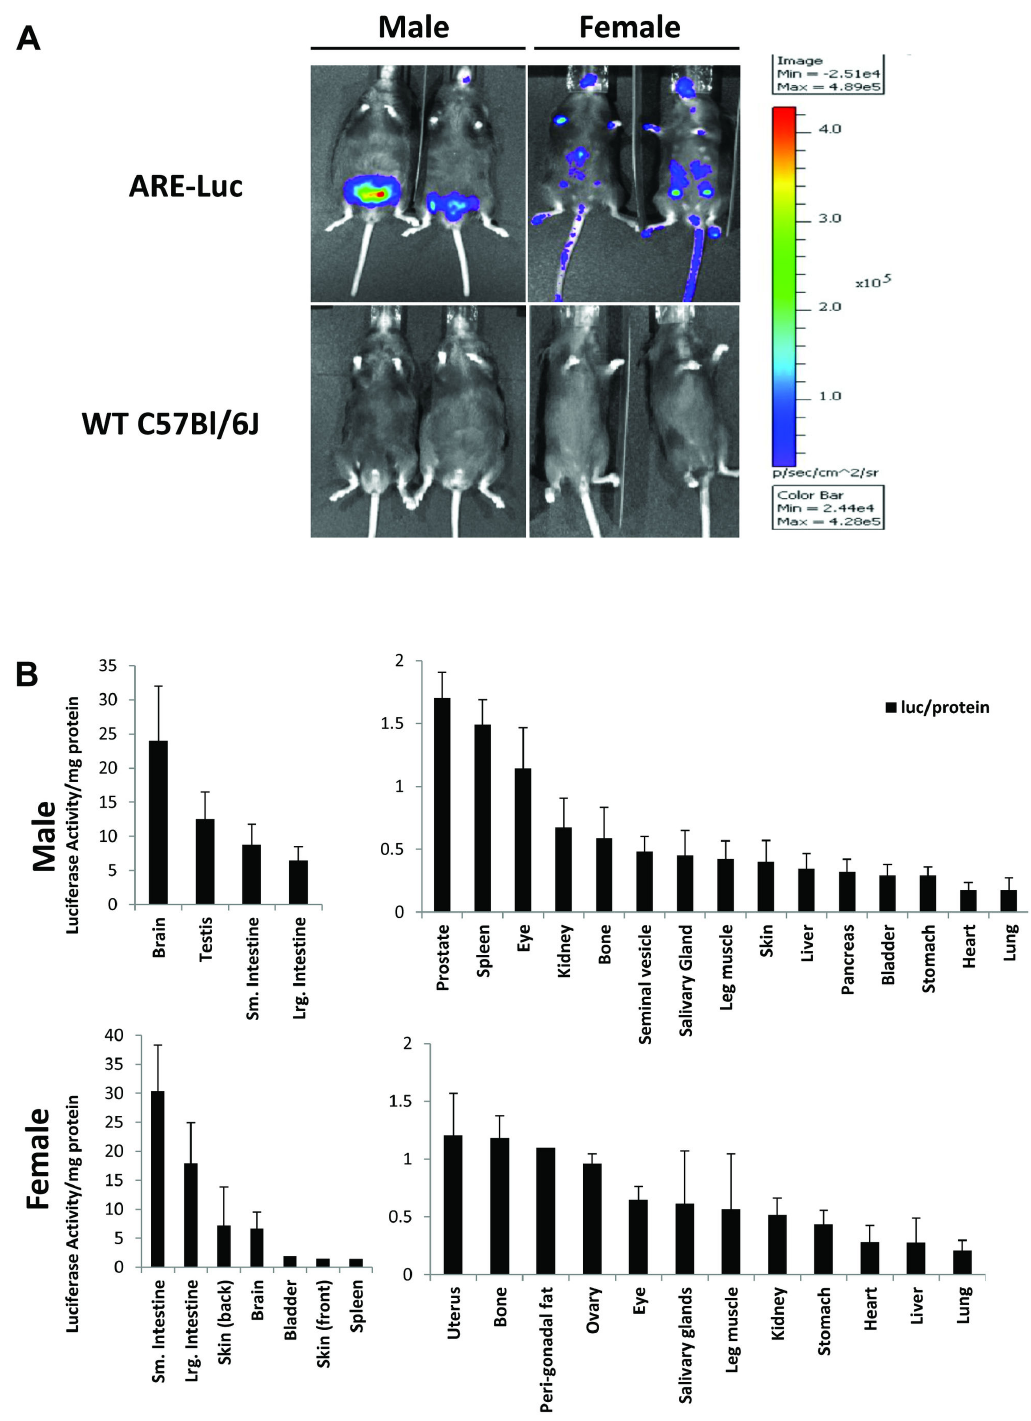
Figure 2. Androgen receptor reporter activity in transgenic mice. ( A ), Bioluminescent imaging of male and female ARE-Luc and C57/Bl/6J wild type mice, injected with 150mg/kg luciferin substrate, and imaged with a CCCD camera after 10 minutes. Figure represents a greyscale photograph overlaid with a pseudocolour representation of bioluminescence; scale represents photons/sec/cm 2 . ( B ), Luciferase enzymatic assays from tissue homogenates taken from ARE-Luc mice, normalised to protein content (Bradford assay). Male mice upper panel, female mice lower panel. doi: 10.1371/journal.pone.0071694.g002 PLOS ONE |